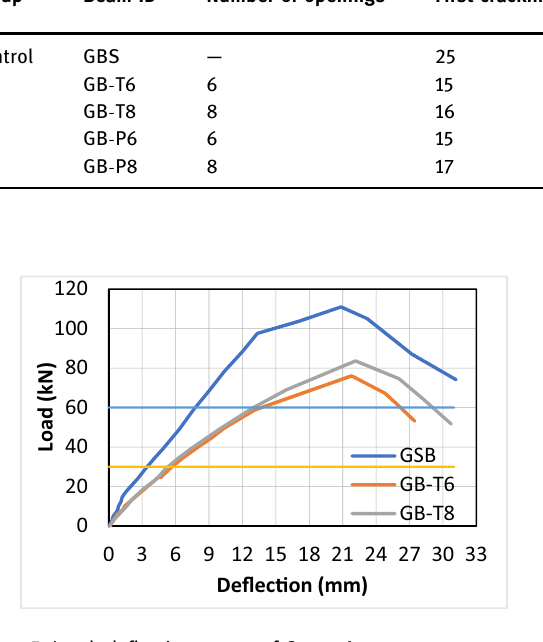
Figure 5: Load – de fl ection curves of Group A.